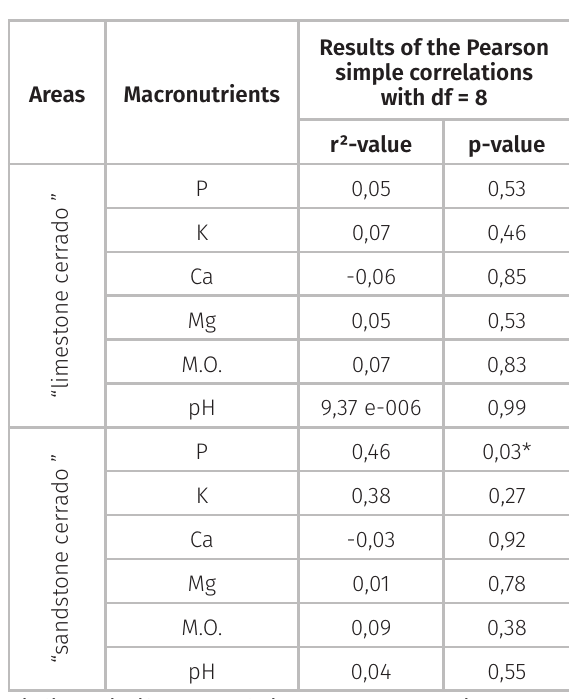
Table II. Simple correlations between the total averages of chemical attributes of the soil and the total variation of the dry mass decay in the “limestone cerrado” and “sandstone cerrado”.